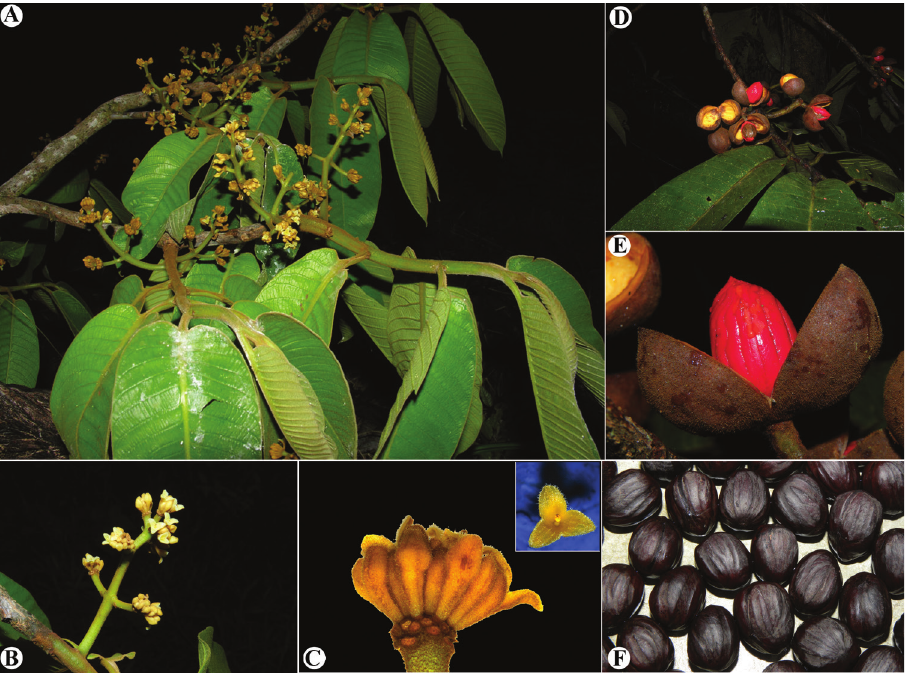
Figure 14. Fertile characteristics of Virola chrysocarpa A branch with staminate inflorescences B stami- nate inflorescences C staminate flower buds and open flower D Infructescence E open fruit F seeds. Photos by Reinaldo